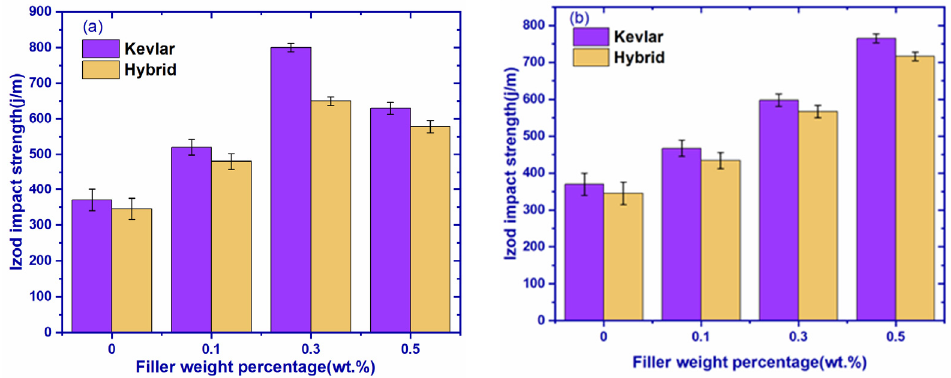
Figure 9. Izod impact strength of ( a ) graphene composites and ( b ) hBN composites.